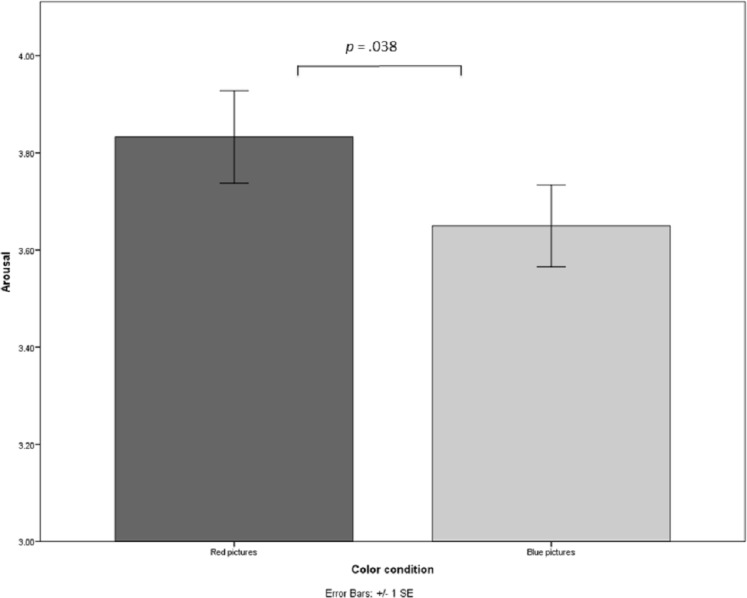
Arousal perceptions of red and blue pictures.